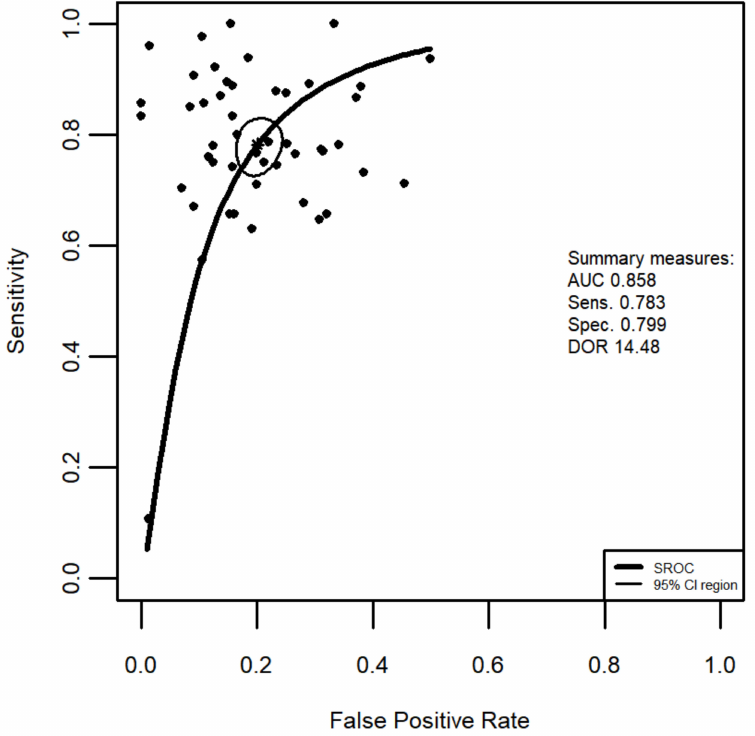
Figure 4. Summary Receiver Operating Characteristic (sROC) curve of the application of FC in the diagnosis of mucosal healing in ulcerative colitis superimposed on Sensitivity and False Positive Rate (1-specificity) results from 49 applications. Summary Sensitivity and summary False Positive Rates are shown as a star, with the 95% CI area circled. Abbreviations: AUC, area under the curve; Sens., sensitivity; Spec. specificity; DOR, diagnostic odds ratio, CI, confidence